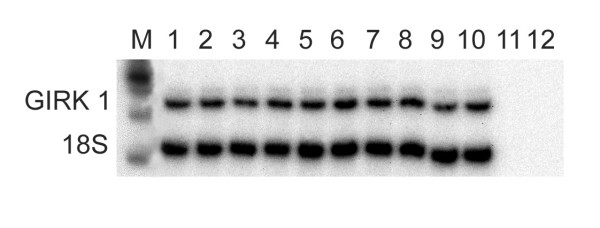
Comparison of GIRK1 mRNA expression levels by relative competitive RT-PCR in MDA-MB-453 cells treated with propranolol for 30 minutes daily for 7 days. Propranolol (1 μM) was added daily for seven days and then removed after 30 minutes. cDNA was amplified by PCR using GIRK1 primers and 18S primers/competimers. Lanes 1–5) untreated control; Lanes 6–10) propranolol treated cells; Lane 11) untreated control, RT reaction without MMLV; Lane 12, MDA-MB453 treated with propranolol, RT reaction without MMLV. Densitometry values were determined using the phosphoimager. Densitometry Girk 1/ Densitometry 18S-control-0.6055 ± 0.0685 (SD); propranolol treated 0.5636 ± 0.0611 (SD). The bands were consistent with the expected sizes, 441 bp for the GIRK 1 primers and 324 bp for the 18S primers/competimers.